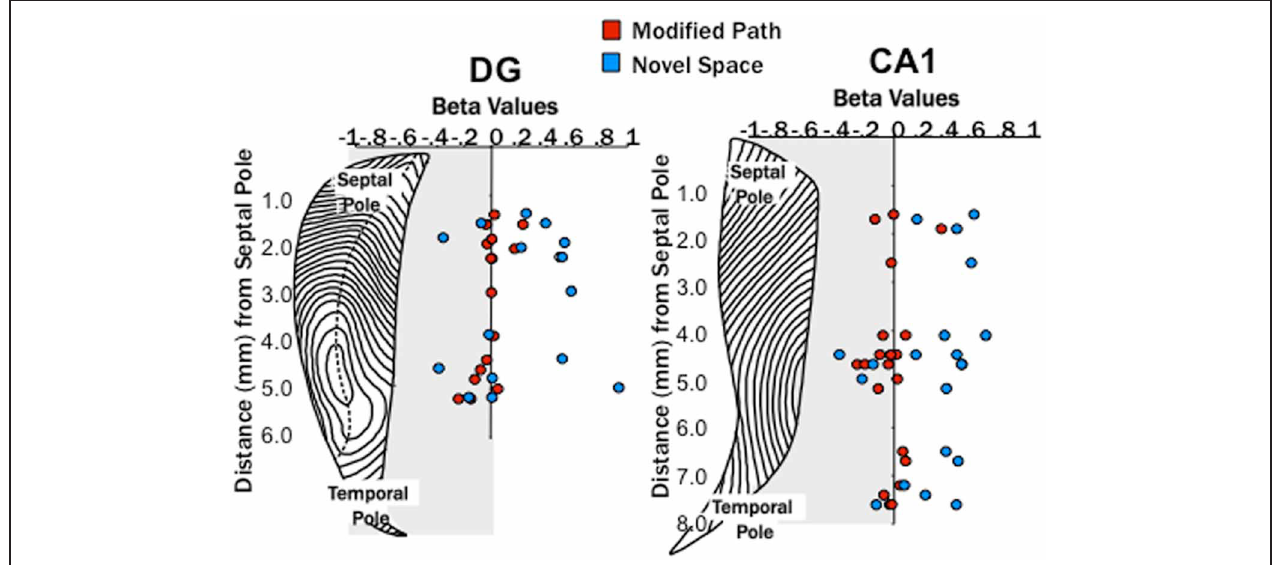
FIGURE 3 | Theta power increased at DG and CA1 sites across the entire septotemporal axis. Distribution of β -values (calculated for each channel from the area of theta power and average speed of each data segment using linear regression analysis) from individual electrode sites within the DG (left) and CA1 (right) at different septo-temporal positions.